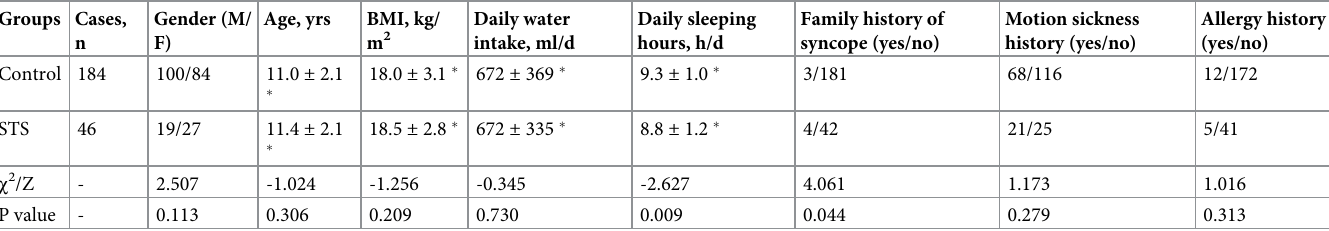
Table 2. Comparison of characteristics between STS group and control group in children. Groups Cases,